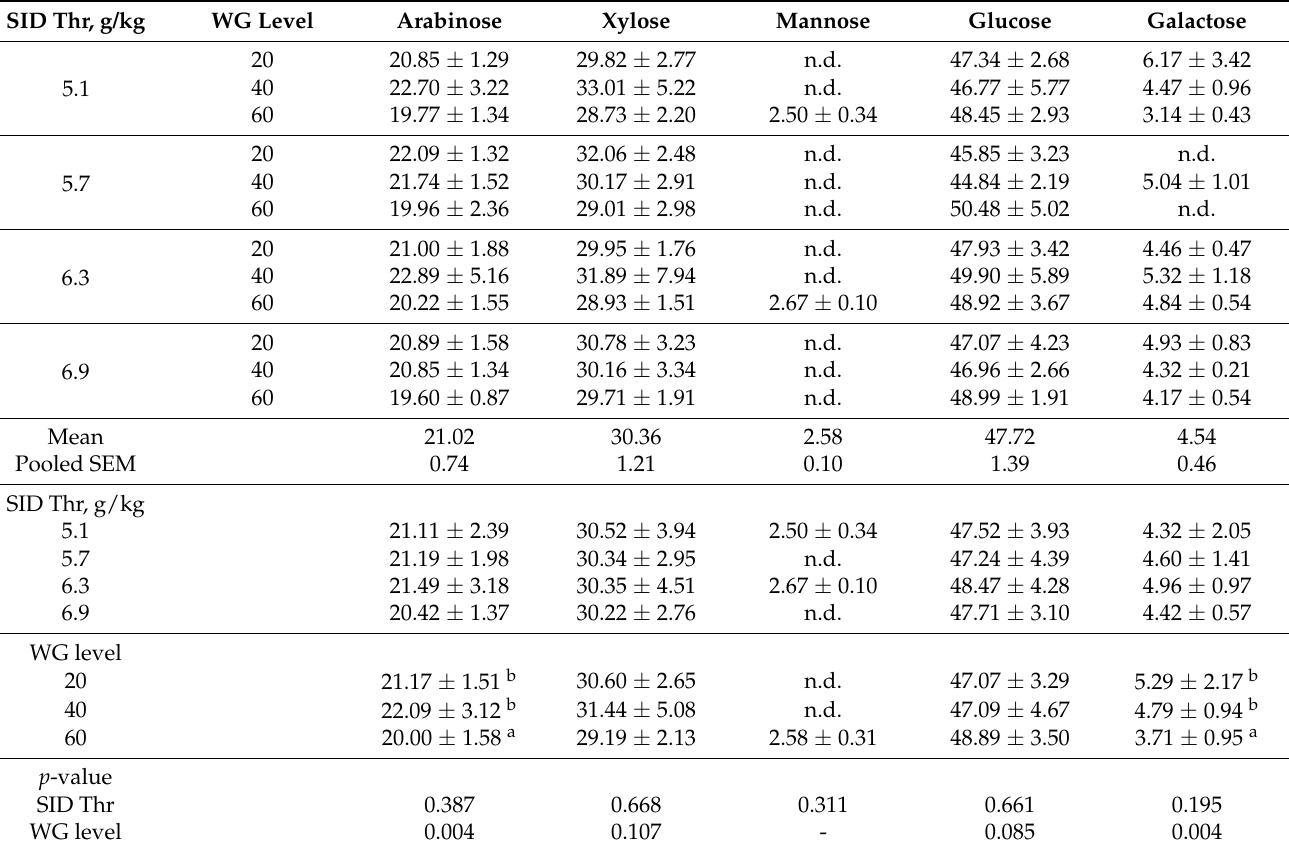
Table 4. Sugar composition (mol/100 mol) in colonic digesta of pigs fed diets differing in